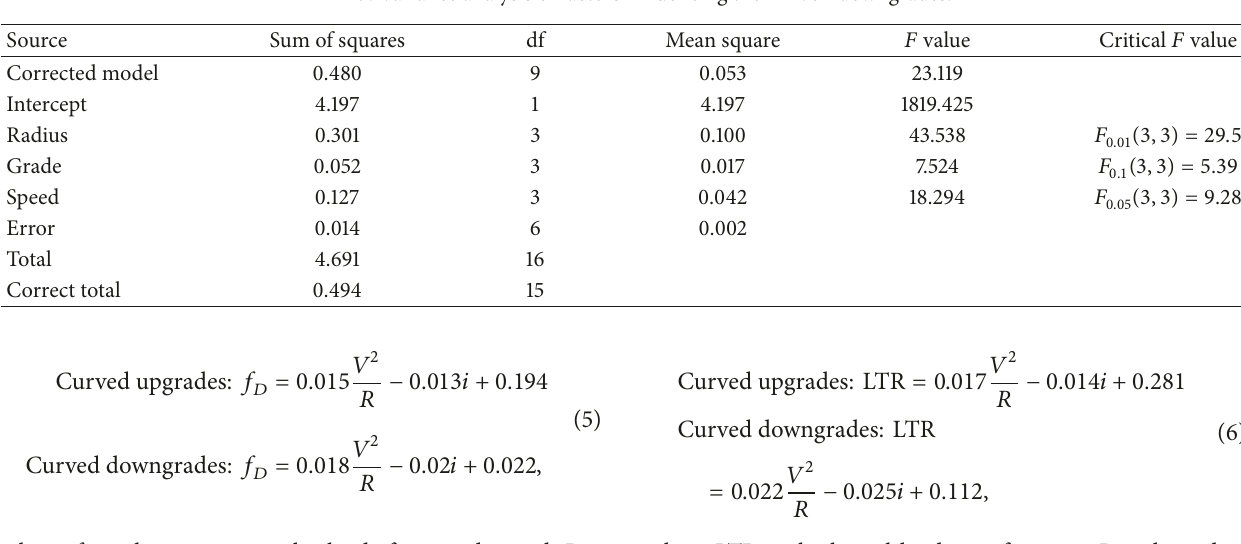
Table 7: Variance analysis of factors influencing the LTR on